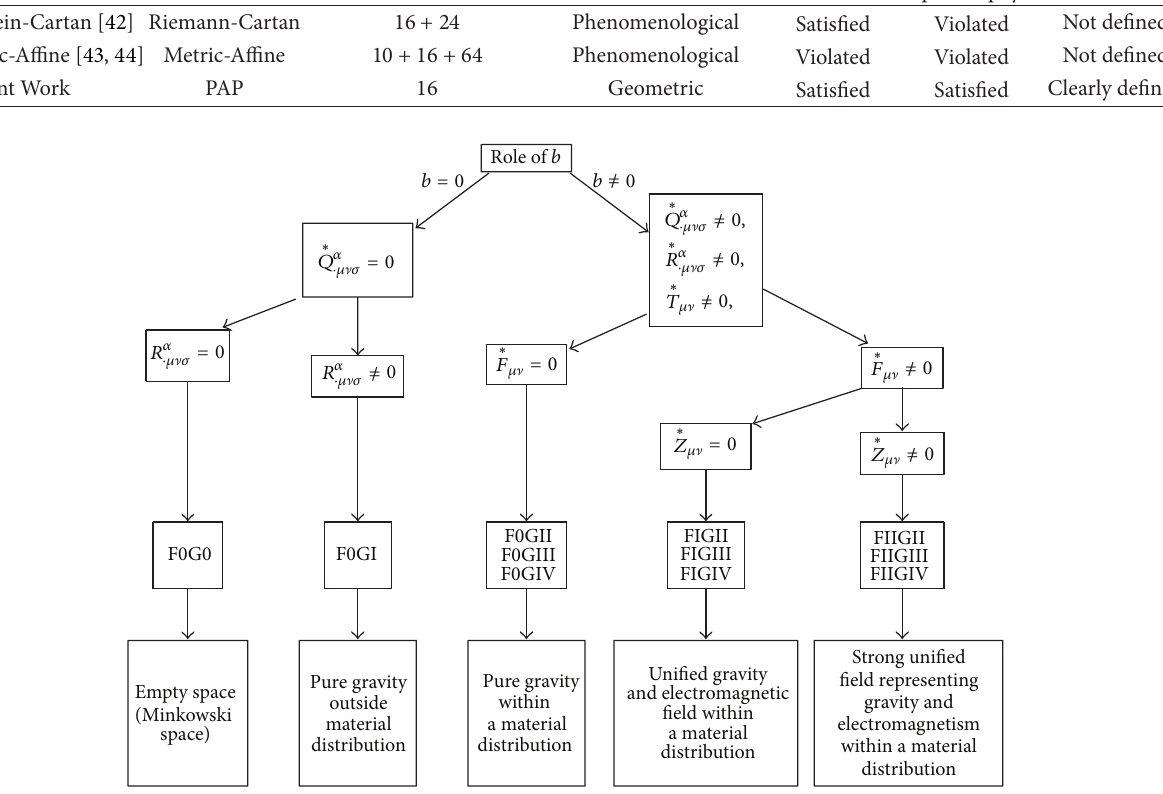
Figure 2: The role of the parameter 𝑏